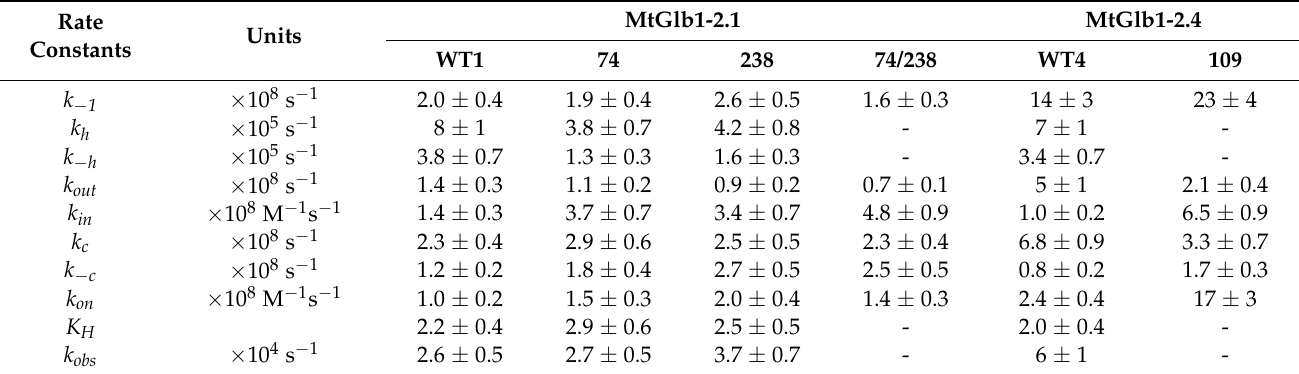
Table 1. Microscopic rate constants from the fit of pump–probe data at room